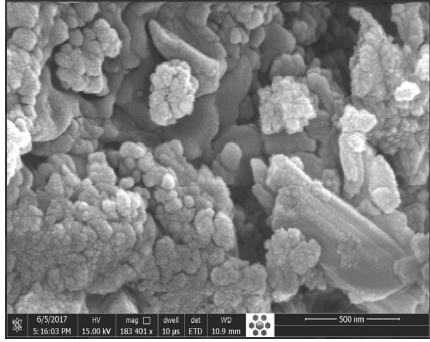
Figure 9: SEM structure of AGB cement mixes.